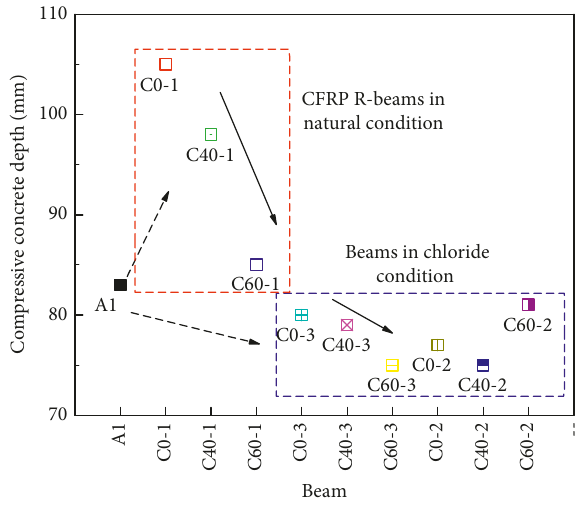
Figure 7: Compressive concrete depths at